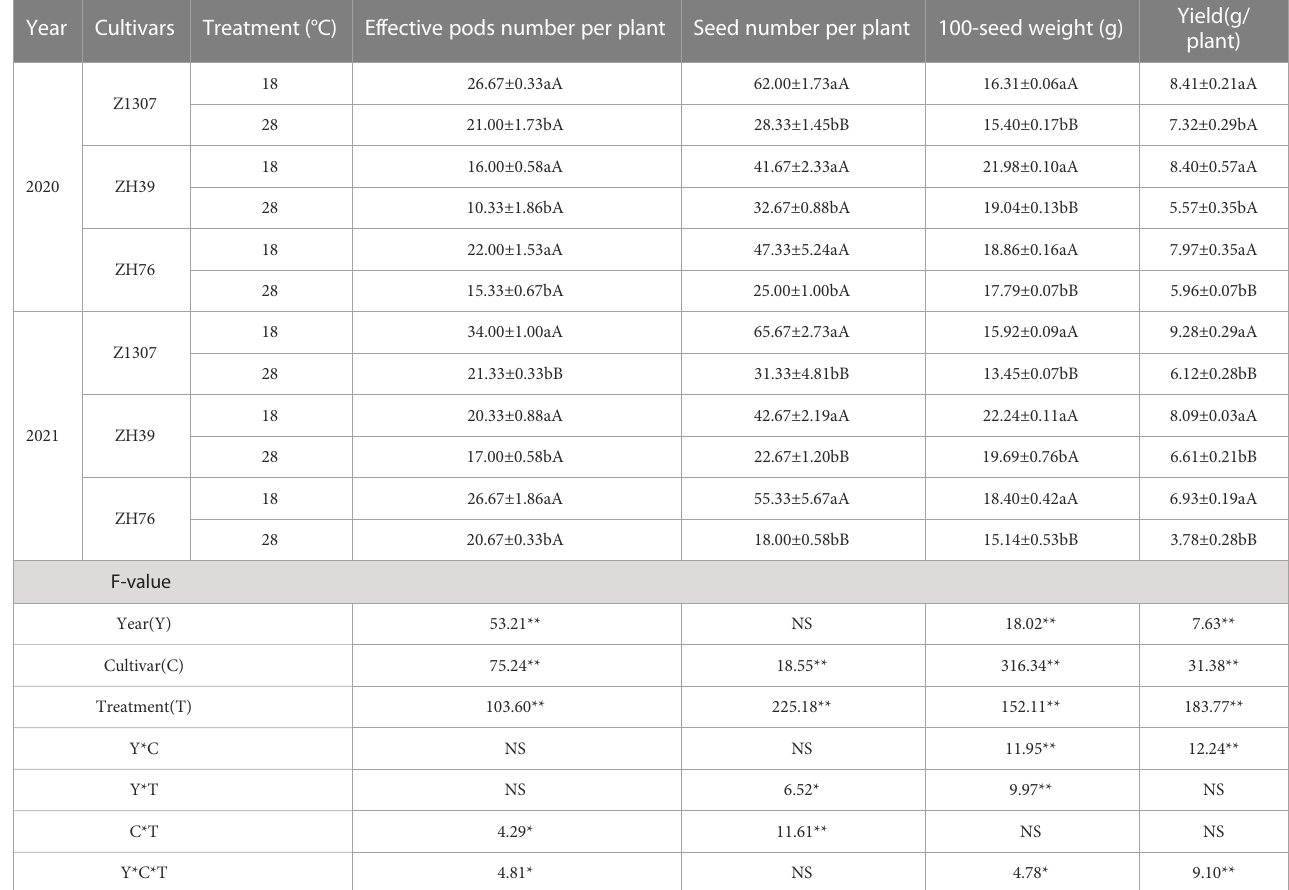
TABLE 1 Effects of different high night temperature on yield and components of